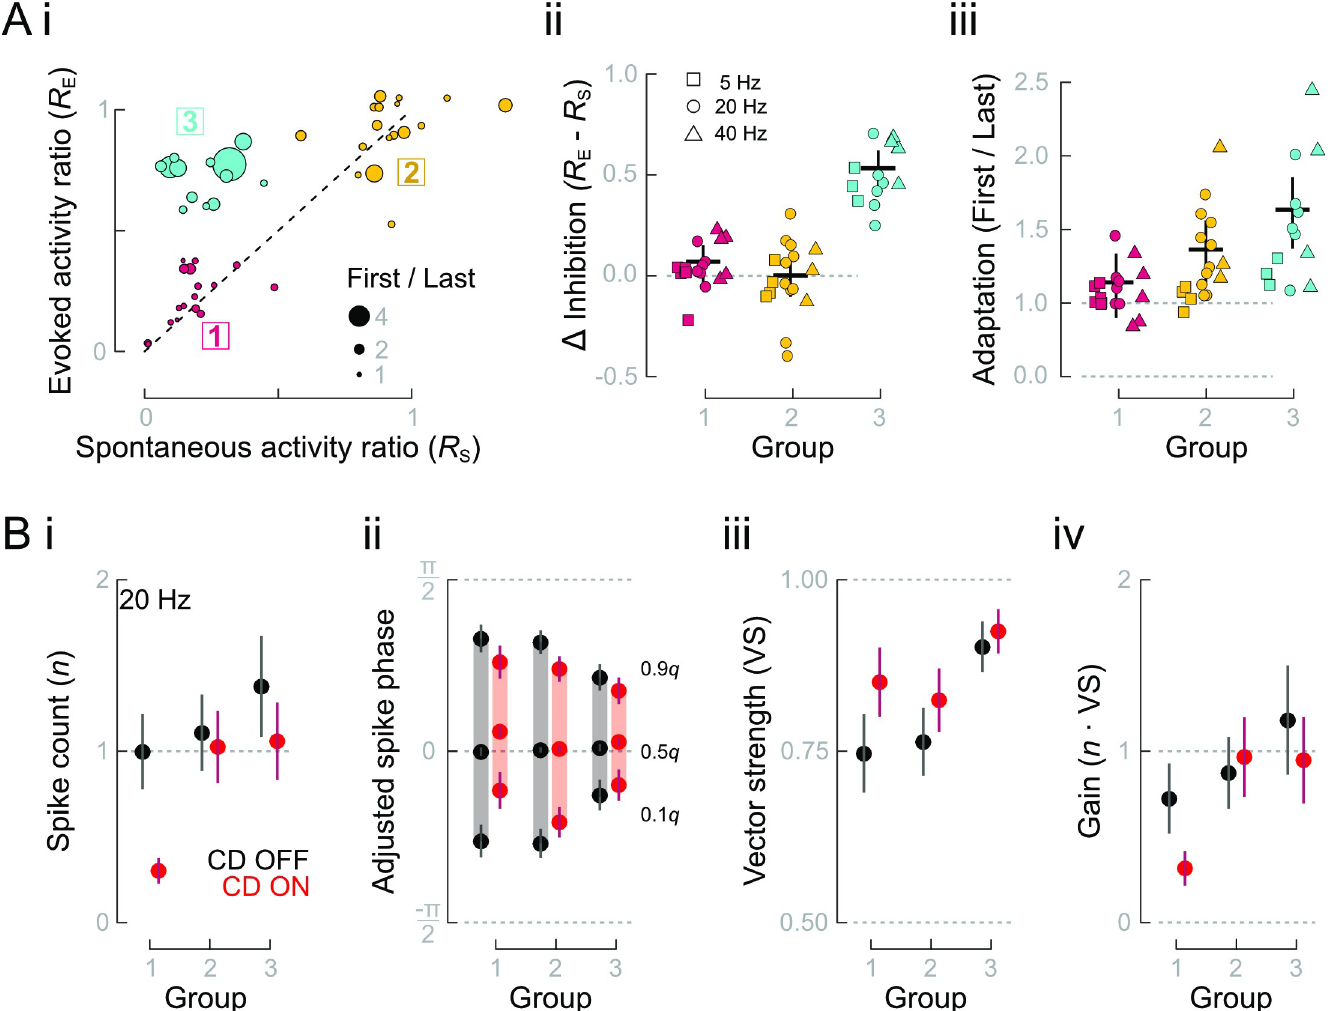
Fig 6. Heterogeneous adaptation rates and CD strengths result in distinct afferent neuron response types. (A) (i) The ratios (CD ON/CD OFF) of evoked and spontaneous activities ( R E and R S ) revealed 3 distinct clusters of response types. (ii) R E and R S were equal in groups 1 and 2 ( Δ Inhibition = 0) but diverged in group 3. (iii) The extent of adaptation increased from group 1 to group 3, shown as First/Last responses to highlight the range of adaptation. (B) Evoked activities and responses to CD differ among response types at 20 Hz. (i) Only groups 1 and 3 exhibited significant CD inhibition, as followed from the cluster analysis. (ii) Group 1 and 2 responses had wider response intervals than group 3, but all groups’ response intervals were narrowed by CD. Additionally, CD ON resulted in a delayed median phase of groups 1 and 3, compared with the median phase of CD OFF. (iii) The larger response interval widths of groups 1 and 2 resulted in lower vector strength that was more impacted by CD, compared with group 3. (iv) Gain was substantially reduced in group 1 responses reduced and constant or slightly increased in groups 2 and 3, although still approximately unity. Data and code underlying this figure and details of statistics and group comparisons may be found at DOI: 10.6084/m9.figshare. 13034012. CD, corollary discharge; VS, vector strength.